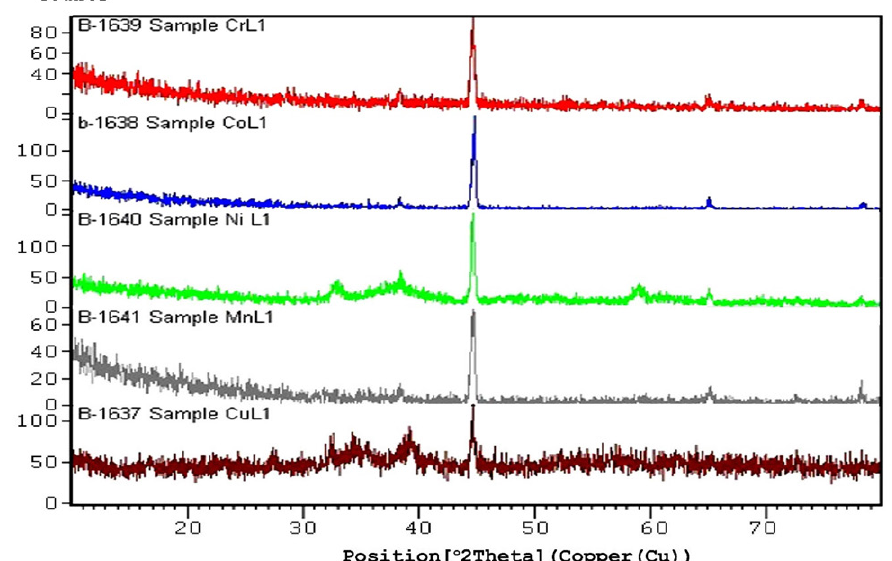
Fig. 4 . X-ray diffraction patterns of complexes [M(L1) 2 (H 2 O) 4 ] +3 with M=Cr +3 , Co +3 and [M(L1) 2 (H 2 O) 2 ] +2 with M= Ni 2+ , Mn +2 and Cu